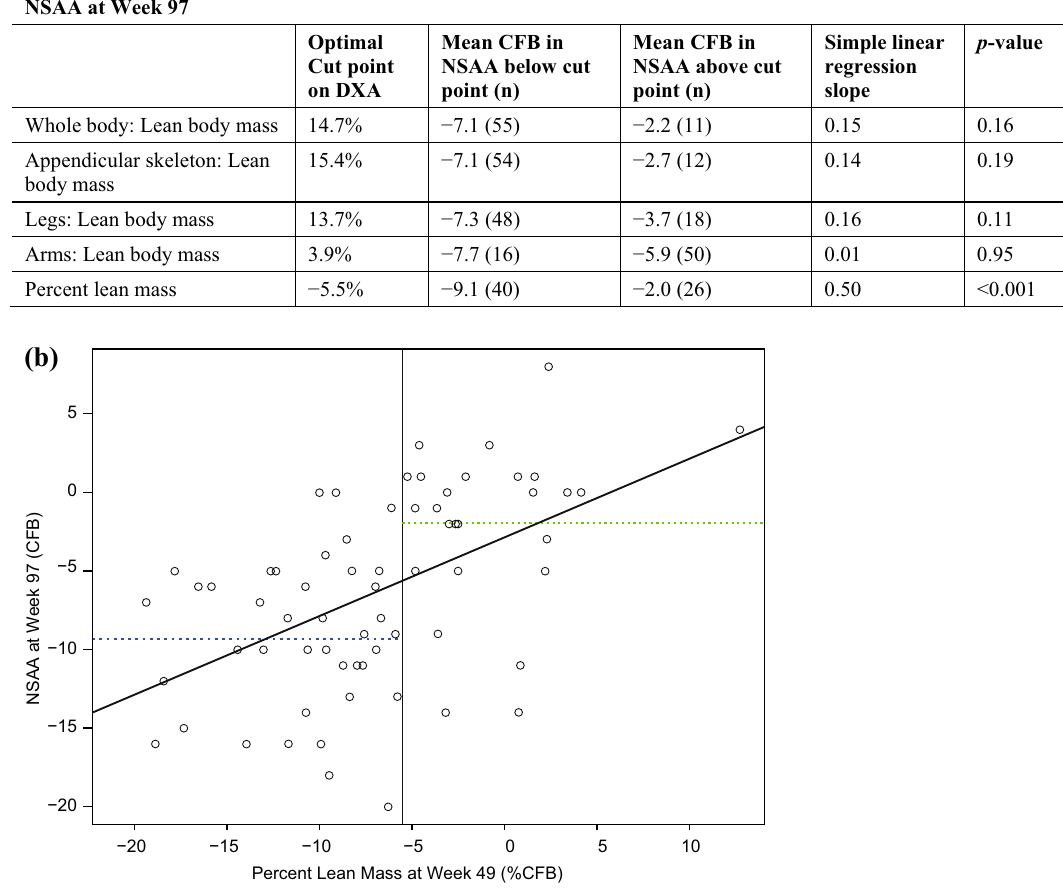
Table 4. Comparison of DXA change from baseline at Week 49 versus NSAA at Week 97. ( a ) Linear regression analysis of DXA %CFB at Week 49 versus NSAA at Week 97 in the overall population, and ( b ) example regression scatter plot showing the relationship between percent lean mass at Week 49 and NSAA at Week 97. In ( b ), the vertical line is the optimal cut point, the blue dotted line is the average response below the cut point, the green dotted line is the average response above the cut point, and the diagonal line is the simple linear regression fit. %CFB, percent change from baseline; CFB, change from baseline; DXA, dual-energy X-ray absorptiometry; n, number in subgroup; NSAA, North Star Ambulatory